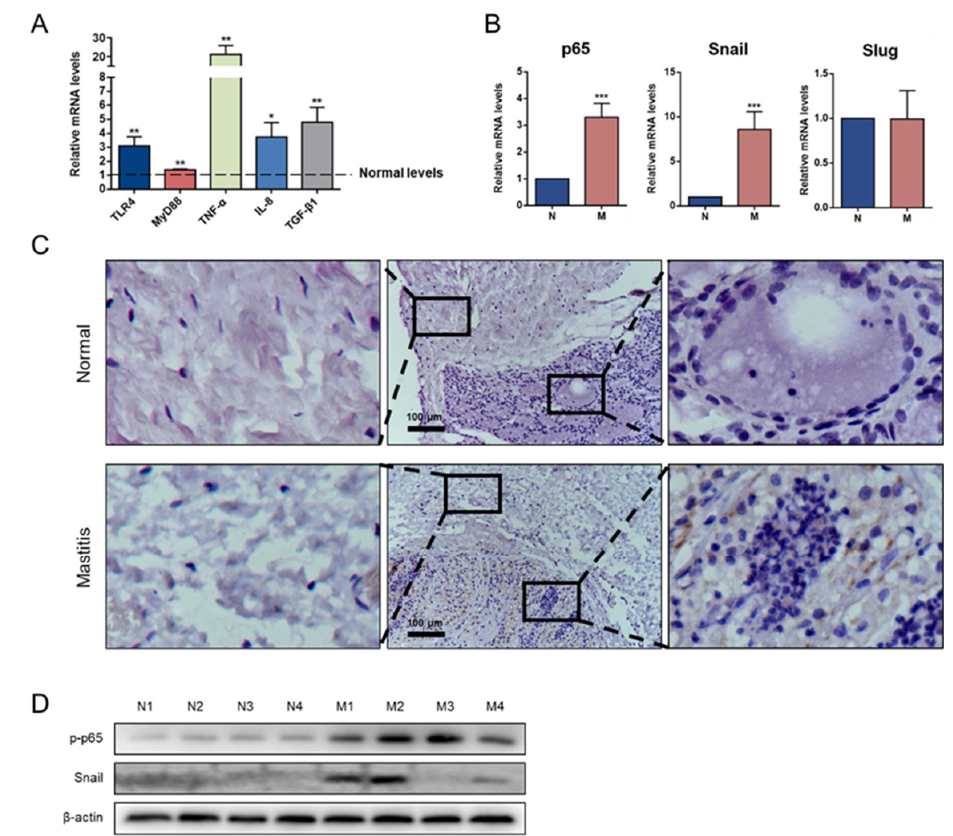
Figure 5. Snail was expressed in goat mastitic tissues. ( A ) mRNA expression levels of TLR4 pathway members and inflammatory cytokines. Normal levels represent the gene expression levels of normal goats. ( B ) mRNA expression levels of p65 and Snail. ( C ) Immunohistochemistry staining showed the localization of Snail in normal (N) and mastitis (M) mammary gland tissues. ( D ) Protein expression levels of p-p65 and Snail in N/M mammary gland tissues. N3 and N4 samples were obtained from the contralateral breast of the same dairy goat. (original western blot figures in Figure S10). * Indicates a significant difference compared with the normal goats, * p < 0.05, ** p < 0.01, *** p < 0.001. Scale bar = 100 µ